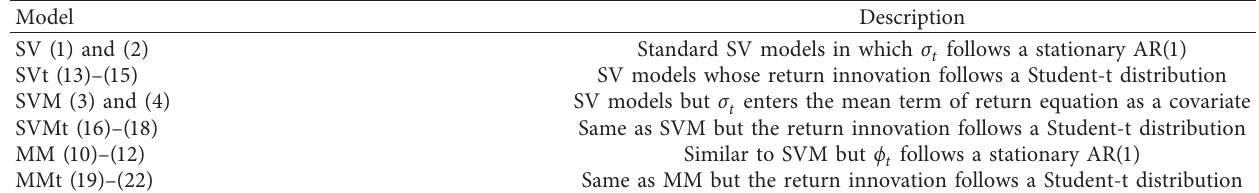
Table 1: List of different stochastic volatility (SV)